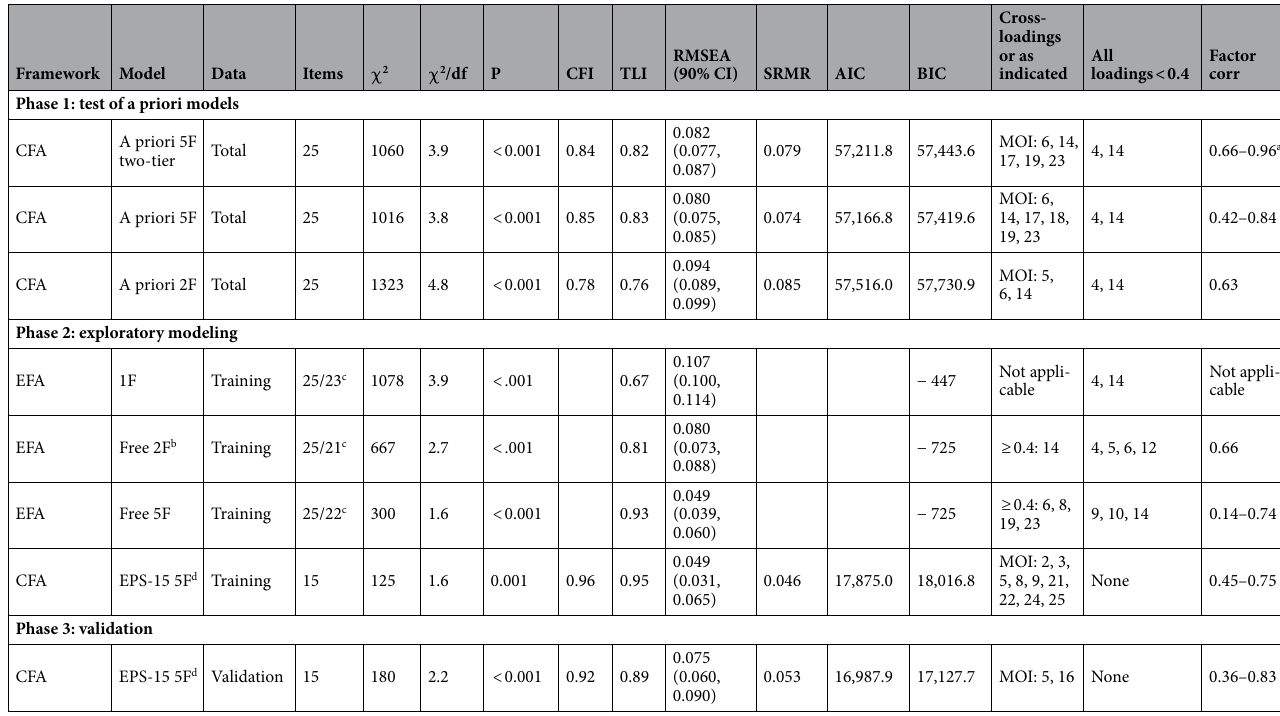
Table 1. Fit indices and other key dimensionality parameters derived from factor analysis of the Emotional Processing Scale-25. Robust fit indices from confirmatory factor analysis. Note that because these models are fitted on different data (the total, training, and validation sample) all values are not directly comparable. Note also that the 2 and 5 factor solutions derived from exploratory factor analysis where all items are allowed to freely load on all factors (that is, cross-loadings are estimated freely over all factors) do not necessarily correspond to other published factor solutions such as those of Baker et al. (2010) or Lauriola et al. (2021). Due to software limitations, fewer fit indices are provided for the EFA models. 2F two-factor, 5F five-factor, AIC Akaike information criterion, BIC Bayesian information criterion, CFI comparative fit index, EPS-15 15-item version of the emotional processing scale, MOI 20 largest modification indices (1-df), RMSEA root mean square error of approximation, SRMR standardized root mean square residual, TLI Tucker Lewis index. a Loadings on the latent “emotional processing” factor. b Arguably the most promising model according to the scree plot, with a clear increase in eigenvalue and deviation from factors derived from simulated data occurring between factor 3 and 2 (see Fig. 1). c Note that while all 25 items were included in the analysis, none of the factor solutions derived from EFA resulted in all 25 items having factor loadings of at least 0.4 on at least one factor. For example, in the 5-factor solution derived from EFA, items 9, 10, and 14 did not load 0.4 or higher on any factor, which means that this was in effect a 22-item solution. d This is the final 15-item factor solution, reached primarily via stepwise modification of the original CFA a priori 5F (non-two-tier) model. See the main text for